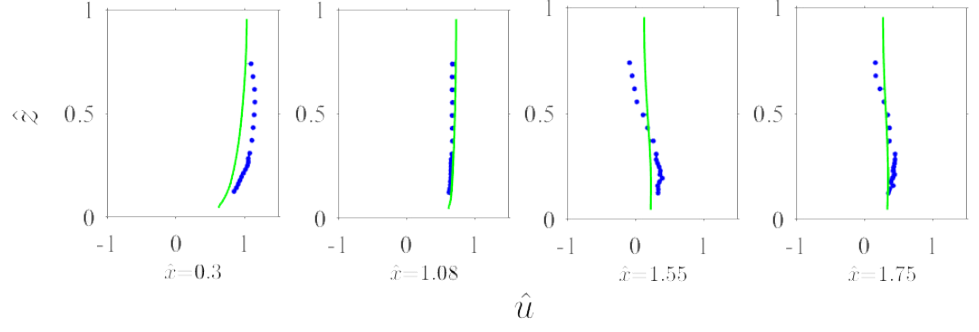
Figure 10. Comparison of measured (blue dots) and simulated (green lines) non-dimensional streamwise velocity component profiles in cross-sections Nos. 1, 3, 7 and 8 along the longitudinal profile ˆ y =